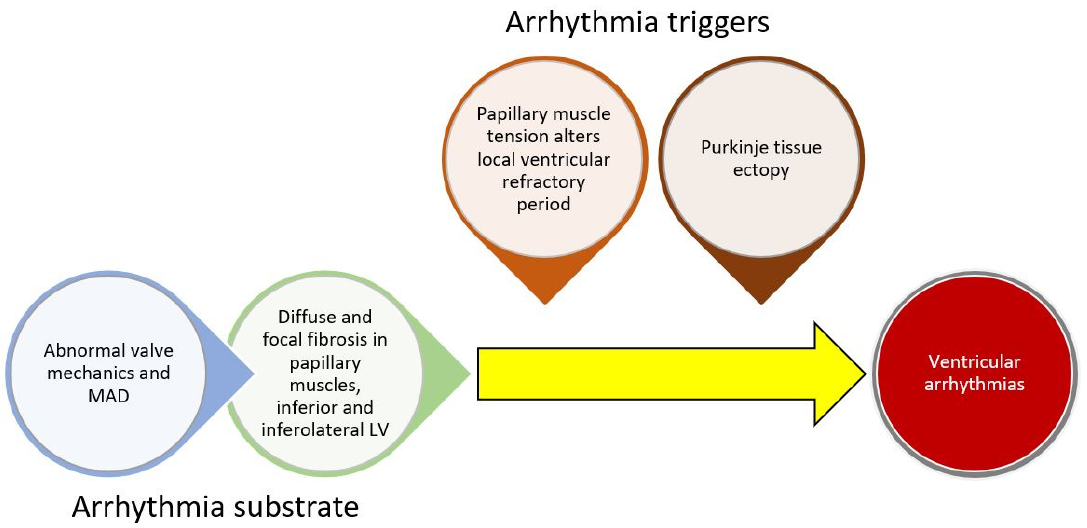
Figure 1. Conceptual framework for ventricular arrhythmogenesis involving the development of cardiac substrate and triggers for arrhythmias.